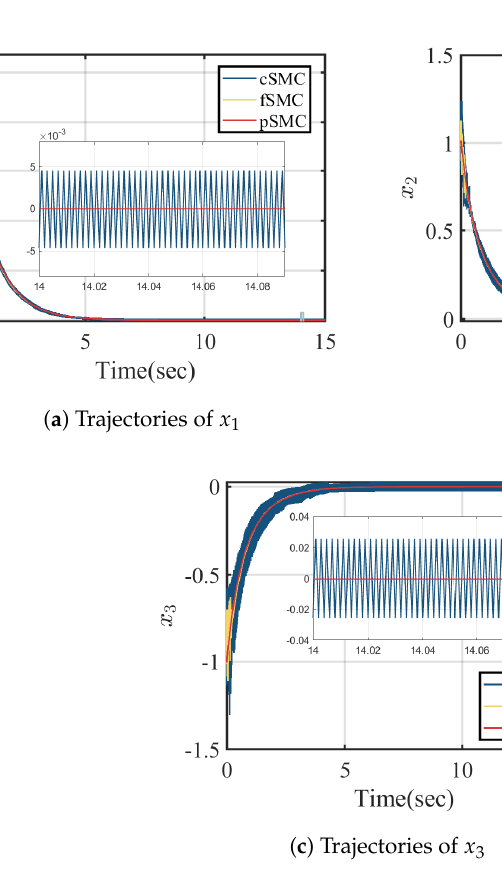
Figure 7. Thetrajectories of state variables x 1 , x 2 and x 3 with continuous approximation when ρ b = 0.9: cSMC (Blue solid line), fSMC (Yellow solid line) and pSMC (Red solid